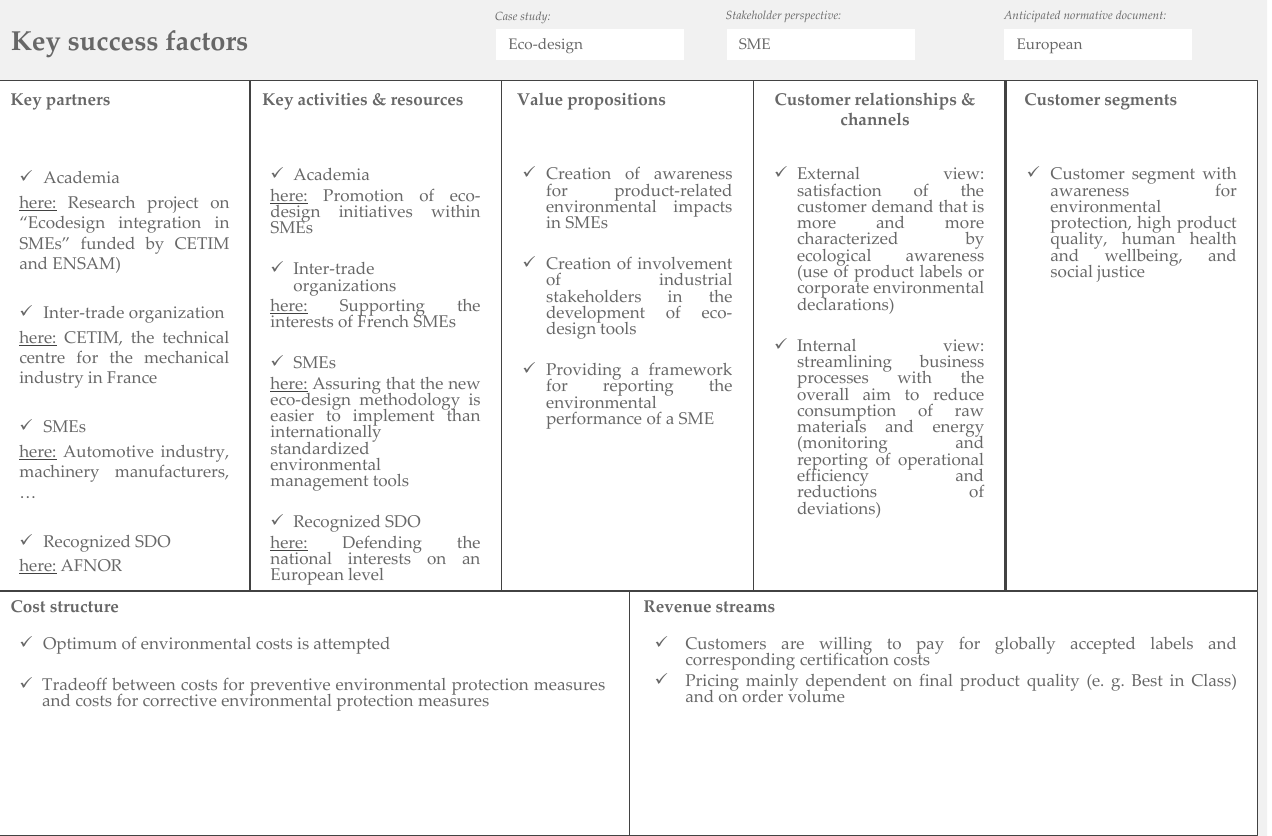
Figure 2. Key success factors for the pre-standardization for the reduction of environmental impacts in product design and